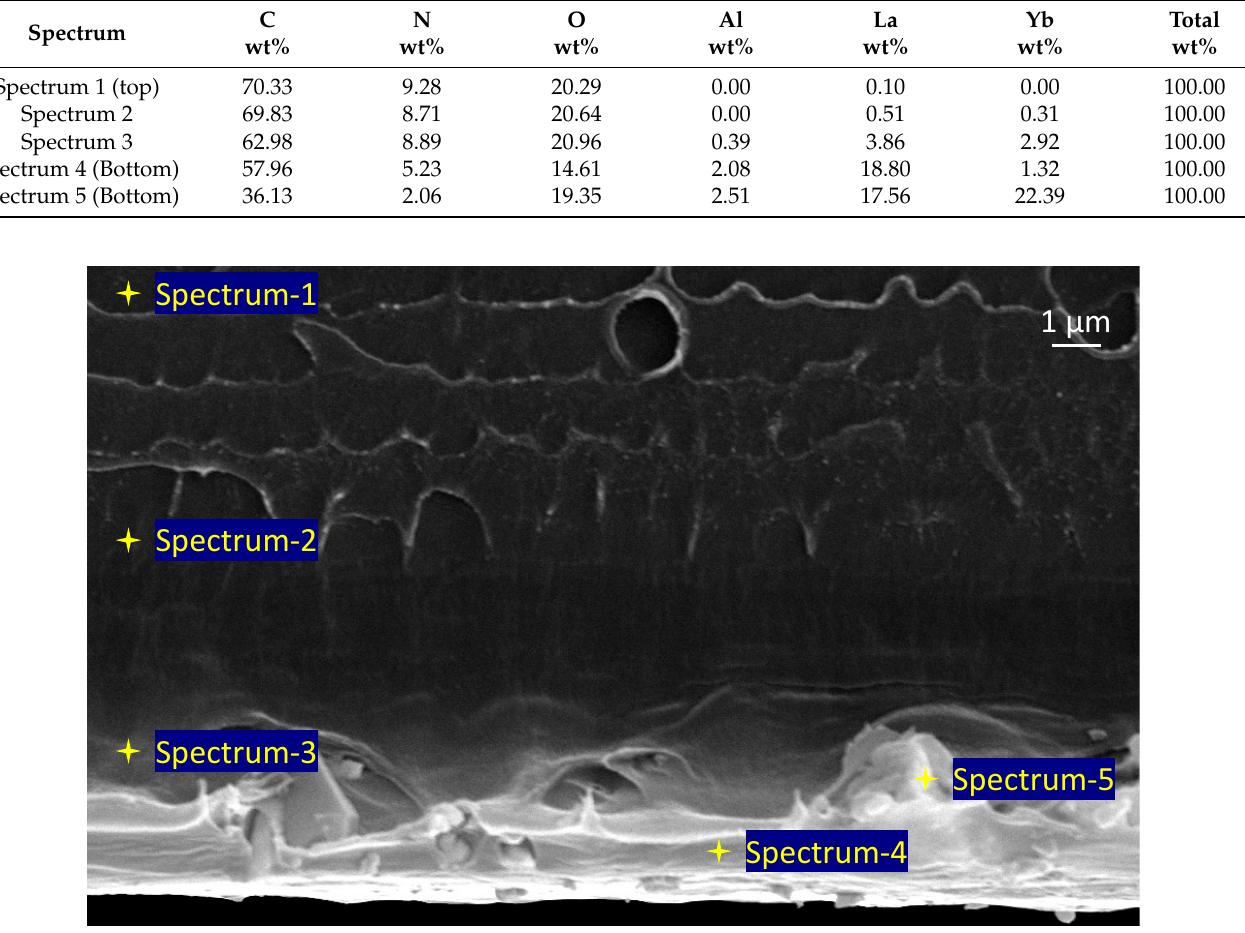
( f ) Figure 6. SEM micrographs of the ( a , c , e ) cross ‐ section (×3,000) and ( b , d , f ) bottom surface (×20,000)